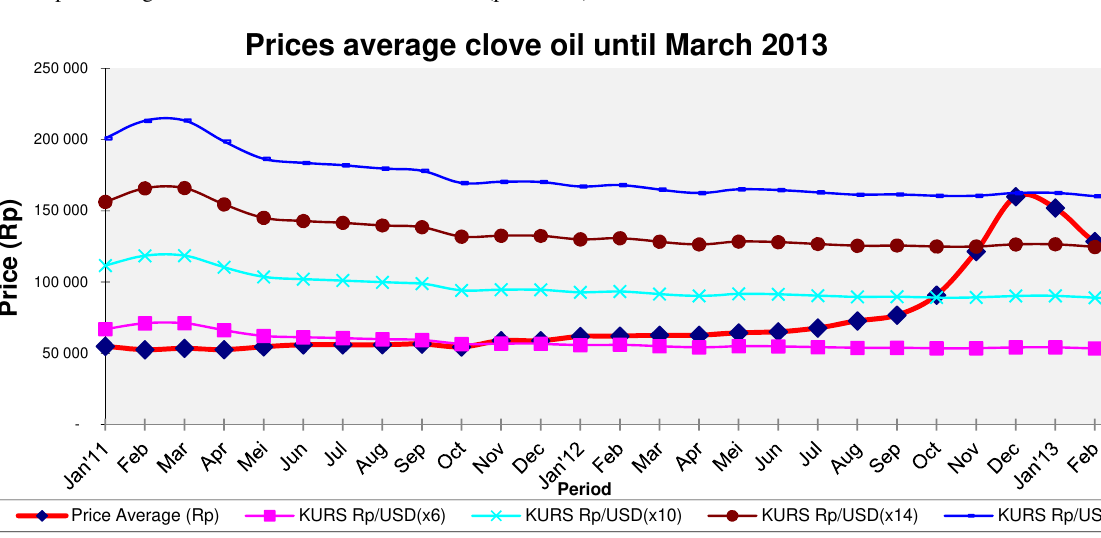
Fig. 3. Purchase price until March 2013 (after price